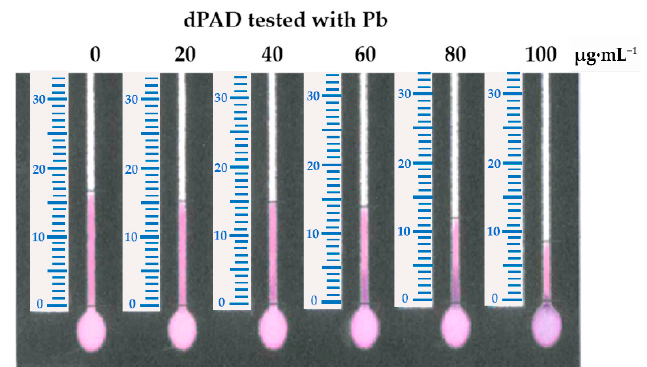
Figure 3. The decrease in the color distance on the PEI-immobilized dPAD observed when introducing Pb at concentrations ranging from 0 to 100 µg·mL − 1 with 0.8 mmol·L − 1 CA in 0.1 M hydroxyethyl piperazineethanesulfonic acid (HEPES) buffer (pH 7.0). The reaction was performed at room temperature for 5 min of incubation.